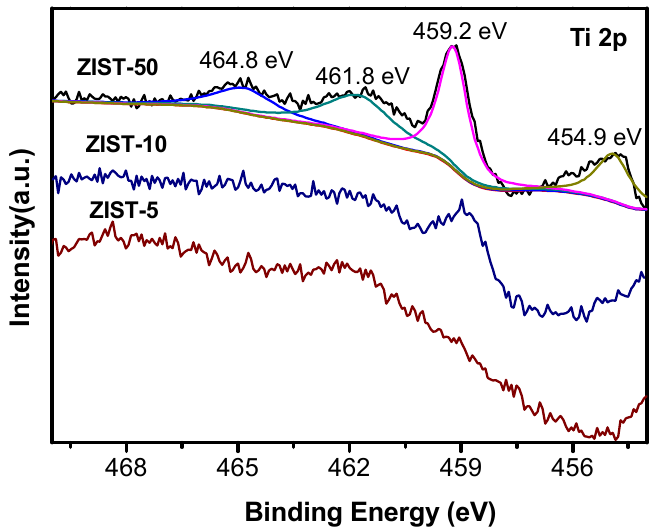
Figure 6. XPS Ti 2p spectra of ZnIn 2 S 4 /Ti 3 C 2 composites with different Ti 3 C 2 content.